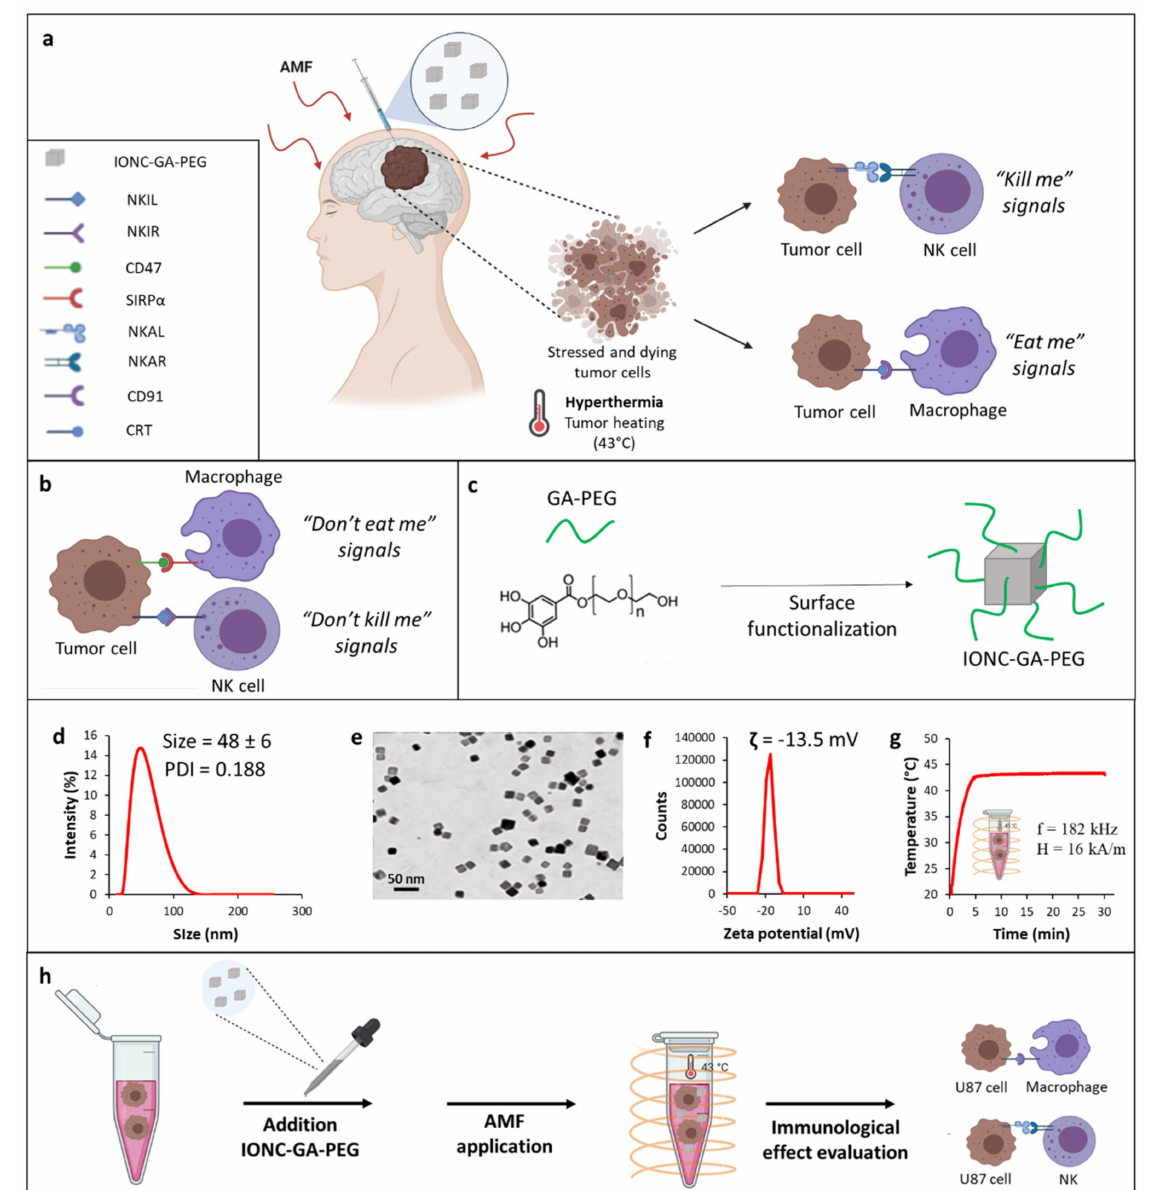
Figure 1. Schematic representation of the innate immunological effect of mild MHT (43 ◦ C) on tumor cells ( a ). Tumor cells express on their surface anti − phagocytic molecules (“don’t eat me signal”), such as CD47, whereby binding to SIRP − α receptor on macrophages impedes macrophage phagocytosis of tumor cells ( b ). Tumor cells can also evade NK cell-mediated killing by increasing the expression of NK inhibitory ligands (NKILs) recognized by specific receptors (NKIRs) on NK cells and downregulating the expression of NK activating ligands (NKALs) responsible for inducing the activation of a receptor − mediated NK killing of tumor cells by engaging specific NK activating receptors (NKARs) on NK cells ( b ). All this results in a “don’t kill me” signal that allows evasion of NK cell immune responses. Mild MHT can revert the TIME thus rendering tumor cells more susceptible to innate immune effectors (macrophages and NK cells) by enhancing the expression of ICD − associated markers, such as CRT engaging the CD91 receptor on macrophages, and concomitantly upregulating NKALs and downregulating NKILs ( a ). Illustration of the functionalization of IONCs with GA − PEG polymer ( c ). Characterization of hydrodynamic size and PDI of IONC-GA-PEG via dynamic light scattering (DLS) ( d ). Representative TEM image of the IONC core coated by GA − PEG polymer (IONC − GA − PEG) ( e ). Zeta potential of IONC − GA − PEG ( f ). Temperature vs time heat profile of IONC − GA − PEG used as heat mediators to reach the desired temperature of 43 ◦ C under an AMF at a frequency, f , of 182 kHz and field intensity, H, of 16 kA/m ( g ). A schematic illustration of the step-by-step in vitro study ( h